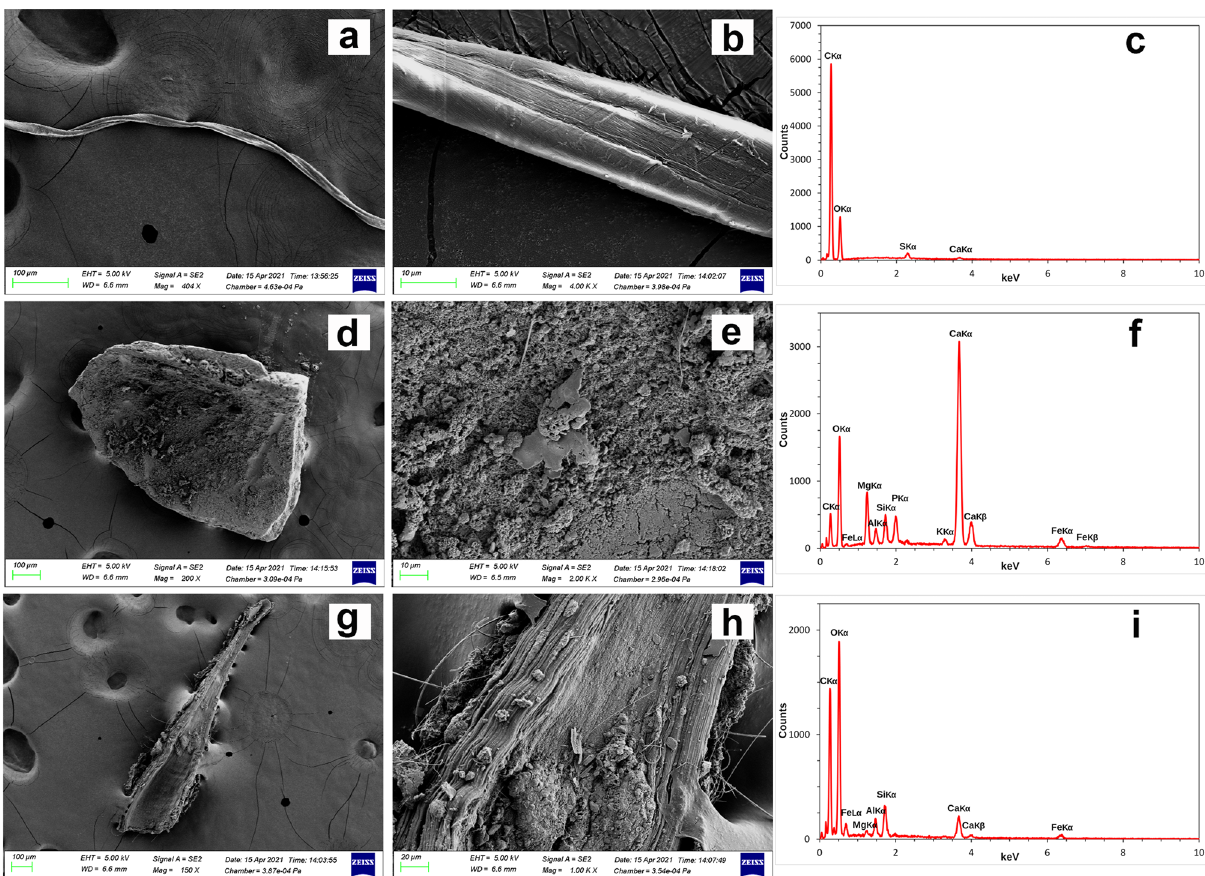
Figure 7. SEM/EDX images and microanalysis from non-plastic materials. SEM images ( a , b , d , e , g , h ) and spectra ( c , f , i ) of non-plastic materials obtained from the stomachal content of collected Bursatella